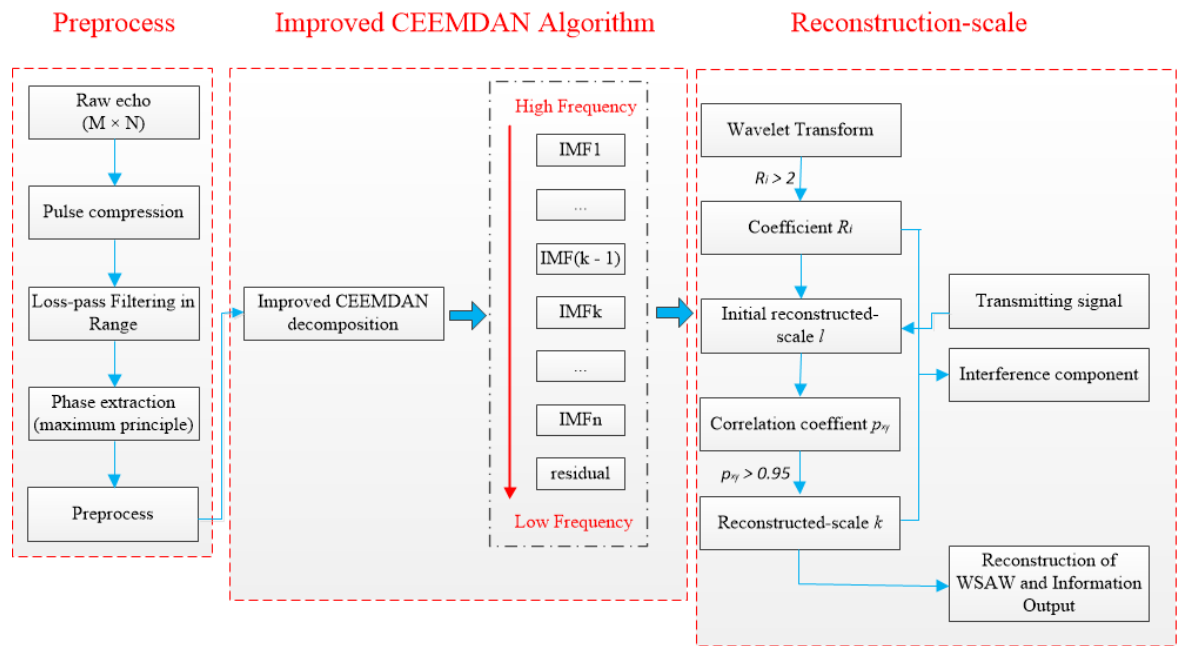
Figure 2. Flowchart of the sea wave interference algorithm.